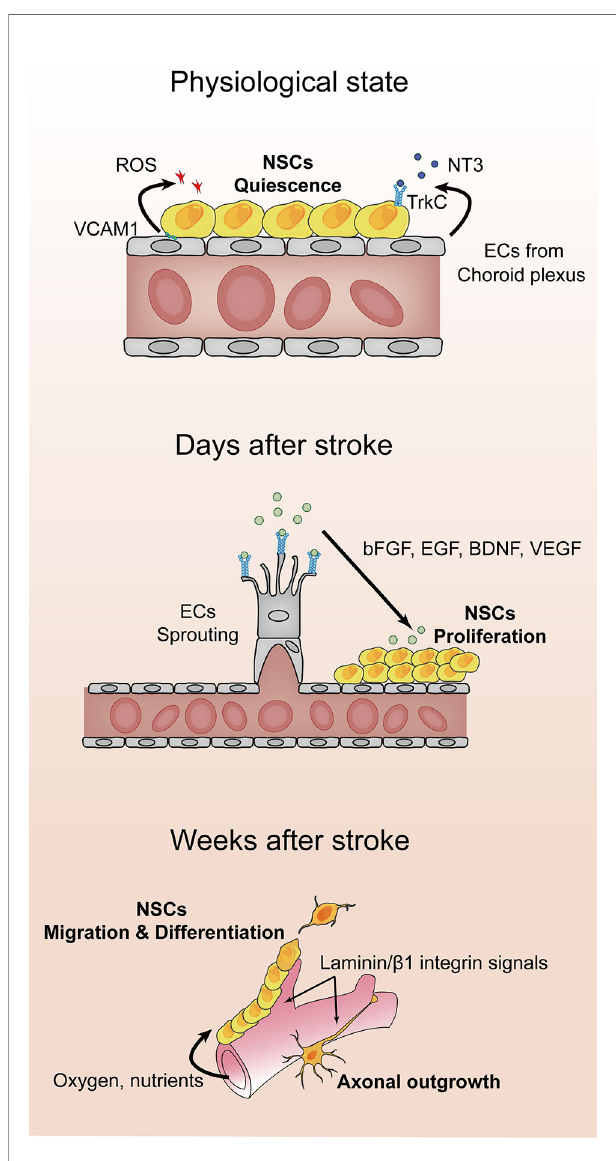
FIGURE 1 | Angiogenesis and neuronal remodeling after stroke. After stroke onset, the hypoxic and ischemic environment triggers vascular sprouting. Vascular endothelial growth factor receptor 2 (VEGFR-2) is expressed on endothelial cells (ECs; shown in gray), where it binds to VEGF-A, which initiates proliferation and protrusion of fi lopodia. Concomitantly, ECs secrete matrix metalloproteinases and endothelial growth factors to facilitate the migration of endothelial progenitor cells and basement membrane degradation. Microvessels are thought to support neural stem cell proliferation by supplying oxygen, nutrients, and a series of growth factors, including basic fi broblast growth factor, epidermal growth factor, and brain-derived neurotrophic factor. Newly formed blood vessels provide guidance for migration and axonal outgrowth through Laminin/ b 1 integrin